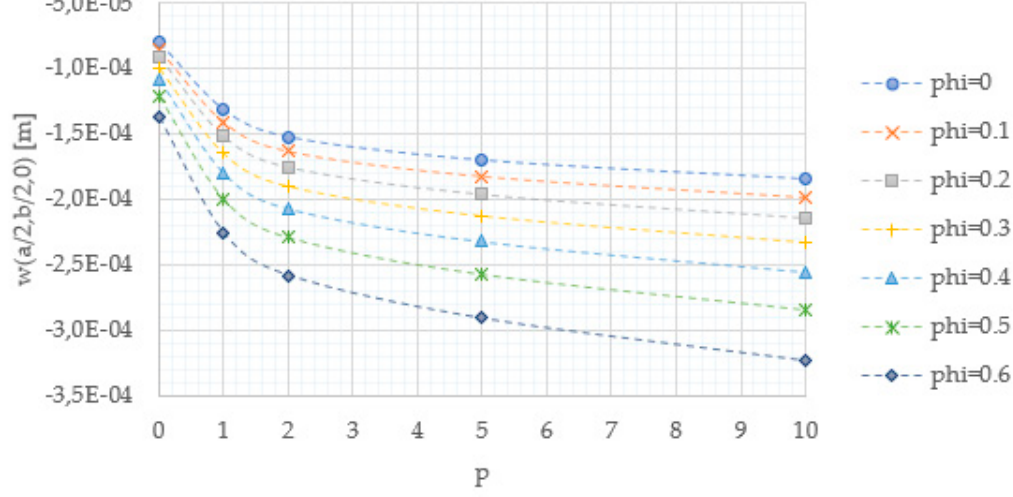
Figure 13. Porosity distribution model M1: evolution of plate’s center transverse displacement.